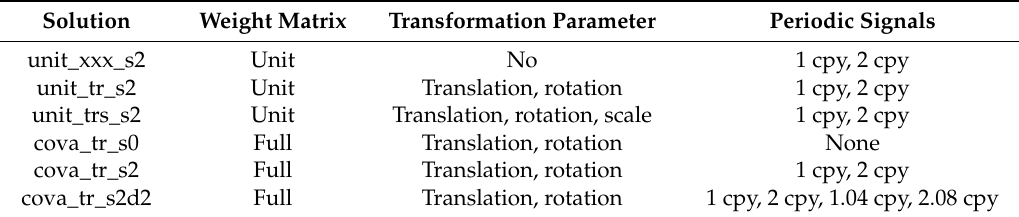
Table 1. Solutions with different strategies for